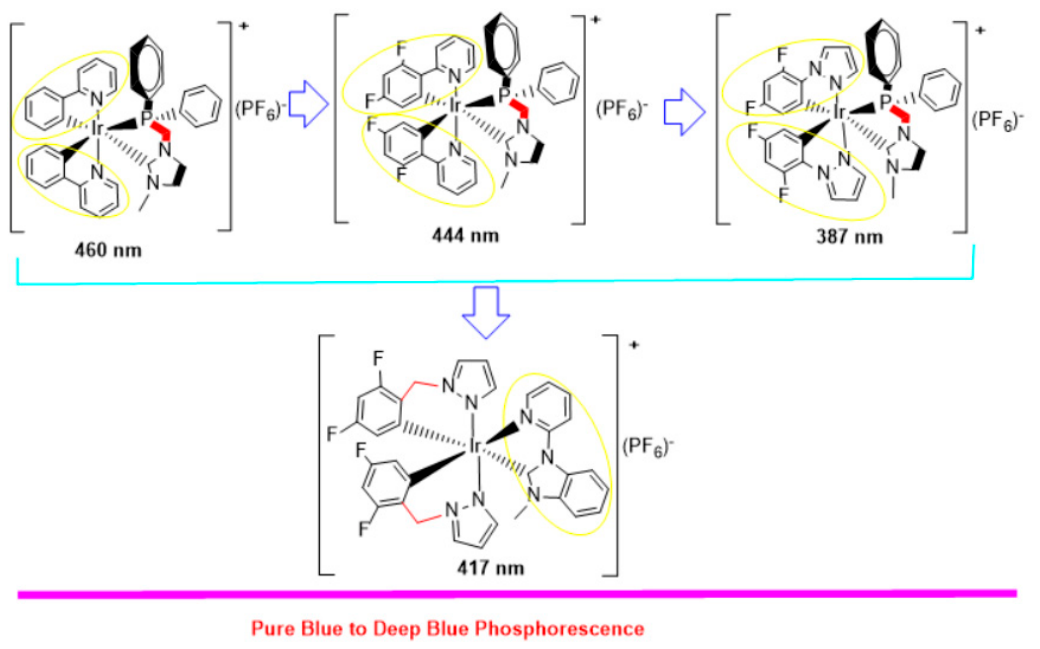
Figure 3. Structures of phosphine containing cyclometalated Ir(III) complexes [71], [Adapted with permission from (Zhang et al.). Copyright (2014) American Chemical Society].